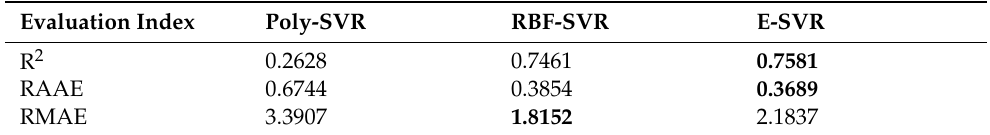
Table 5. Hartman3 function test